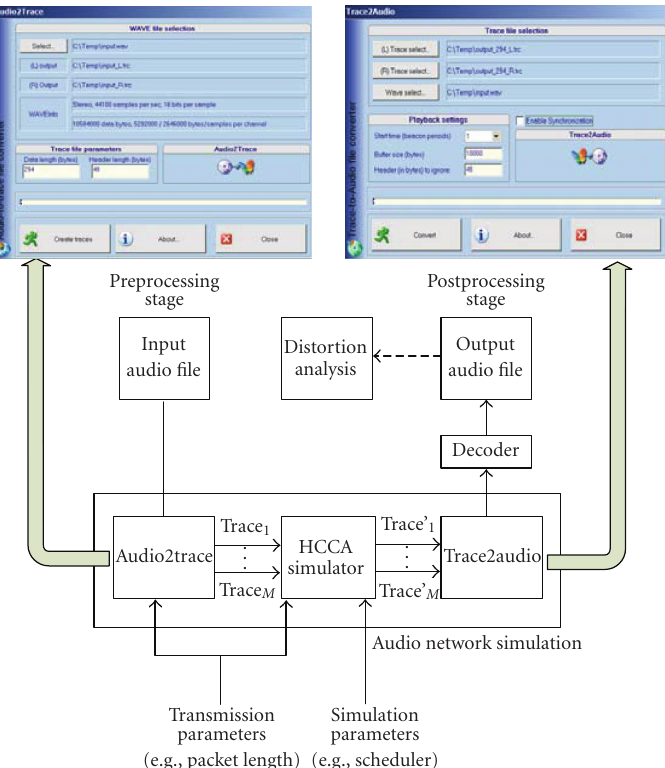
Figure 5: Block diagram of the WLAN audio delivery